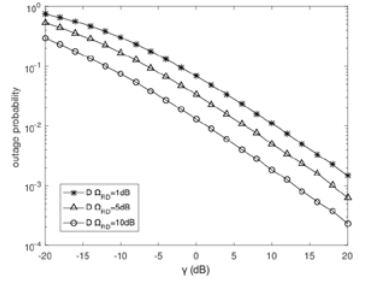
Fig. 3. Outage probability against γ with